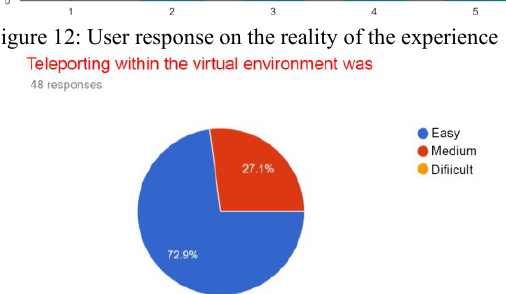
Figure 13: User response on the ease of teleporting